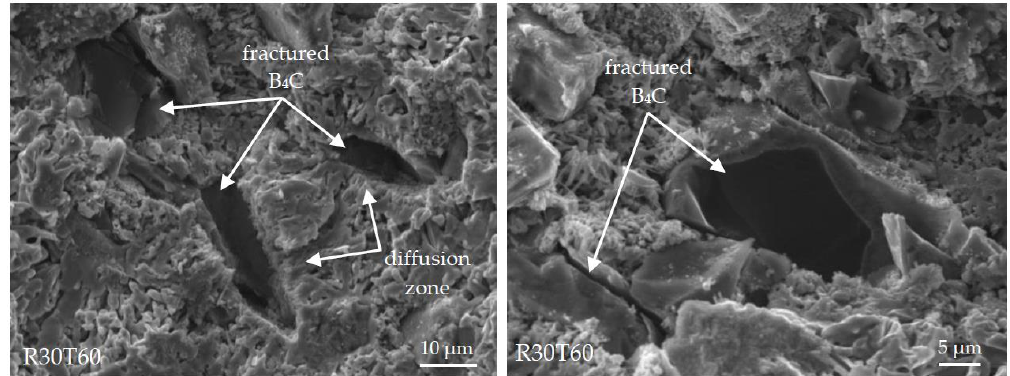
Figure 21. ( a ) SEM images of fractured surfaces from the 60 min sintered Fe + 10 vol.% B 4 C test specimen; ( b ) EDS analysis of the points indicated by the dashed arrow line in (a): A iron matrix and B borided zone.